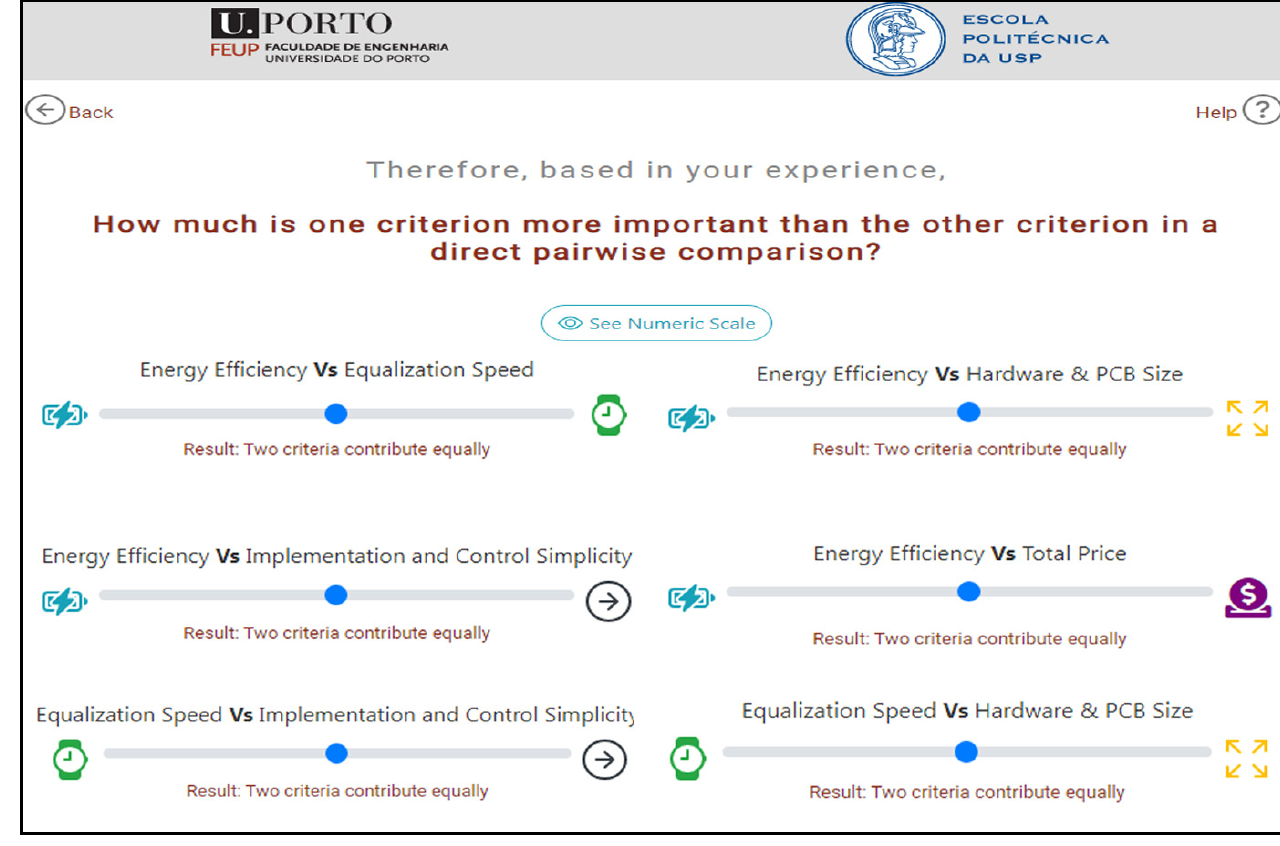
Figure 2. Multiplatform browser application developed to ask and obtain the AHP numerical scale for pairwise comparison matrix A .